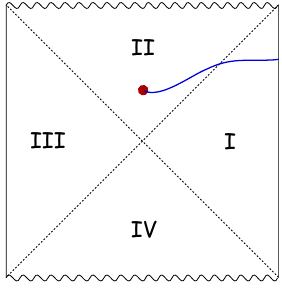
Figure 2: The charged scalar connected to the right boundary via a Wilson line is a gauge- invariant bulk operator, carrying charges Q